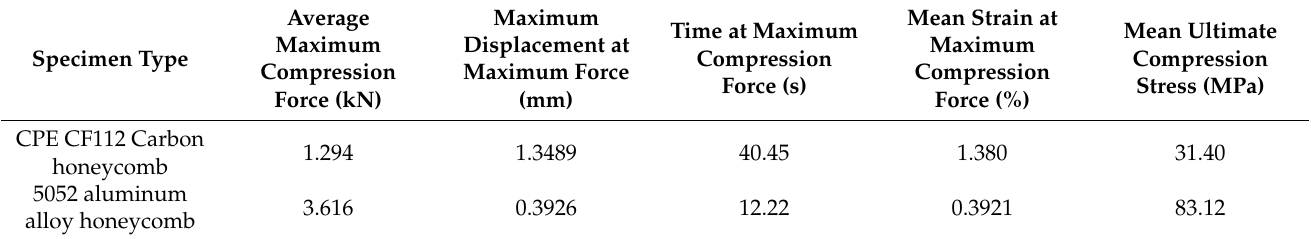
Table 9. Comparison between the average performances of the two honeycomb